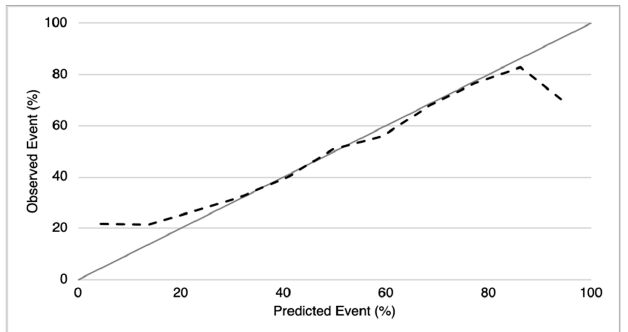
Figure 3. Smooth Calibration plot for the validation of CFZ CVAEs Risk Score. Comparison between observed and predicted CVAEs based on bootstrap. The grey line represents the perfect condition in which the observed CVAEs are equal to predicted CVAEs; the black line represents the CVAEs observed in our population.